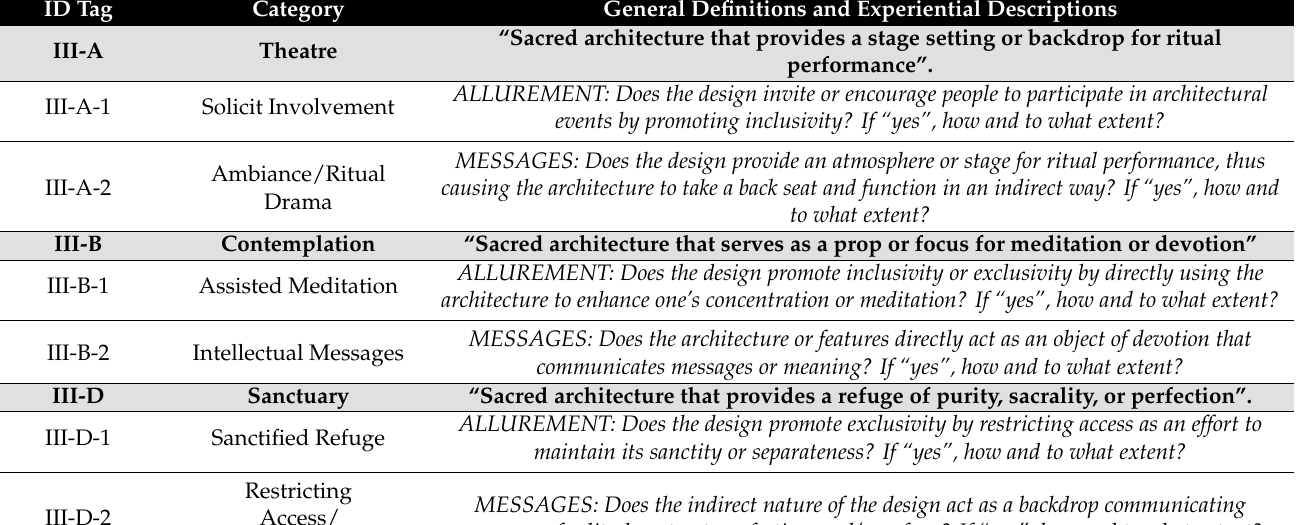
Table 4. Six questions for researchers to ask for Jones’ ritual contexts during graphical analysis for a particular case